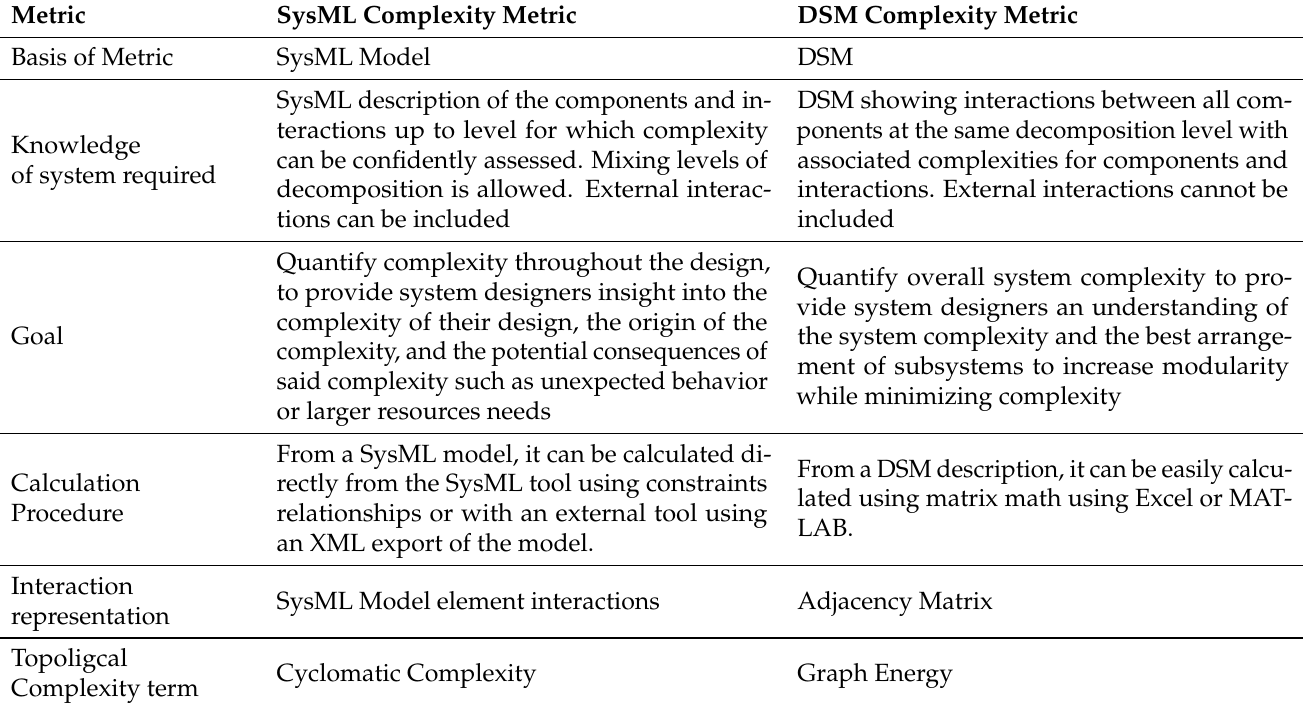
Table 1. Summary comparison between SysML complexity metric and DSM complexity metric